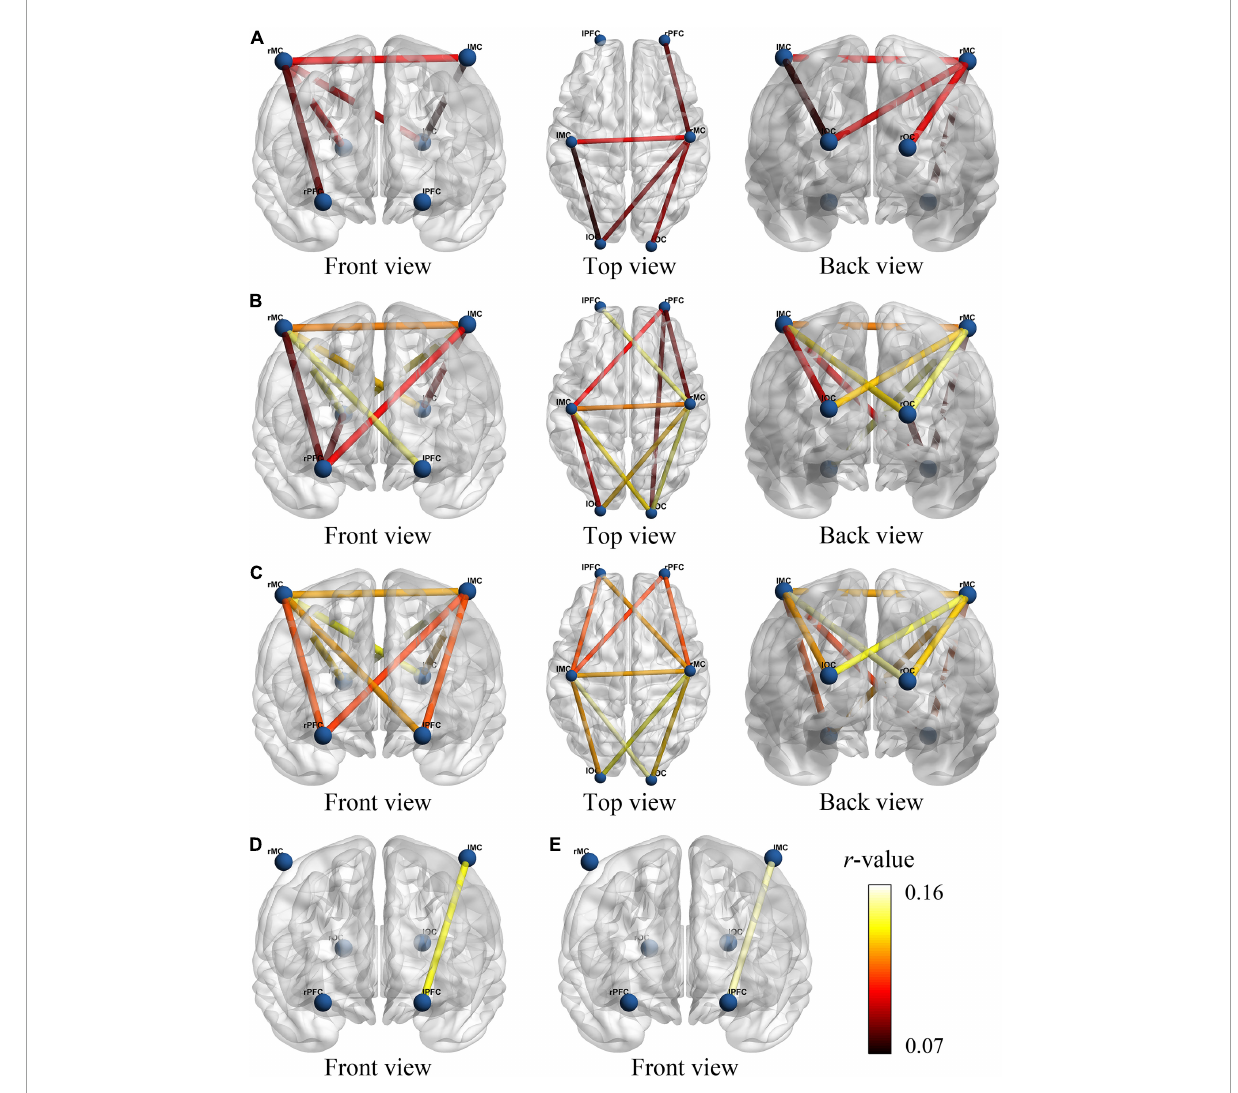
FIGURE3 The functional connectivity visual map under different viewing angles. The connectivity line indicates the significant changes of r -value between resting and initial stage (A) , resting and intermediate stage (B) , resting and sprint stage (C) , initial and intermediate stage (D) , initial and sprint stage (E) . The blue nodes represent six brain regions. Line color indicates the connectivity intensity, and the brighter color represents higher